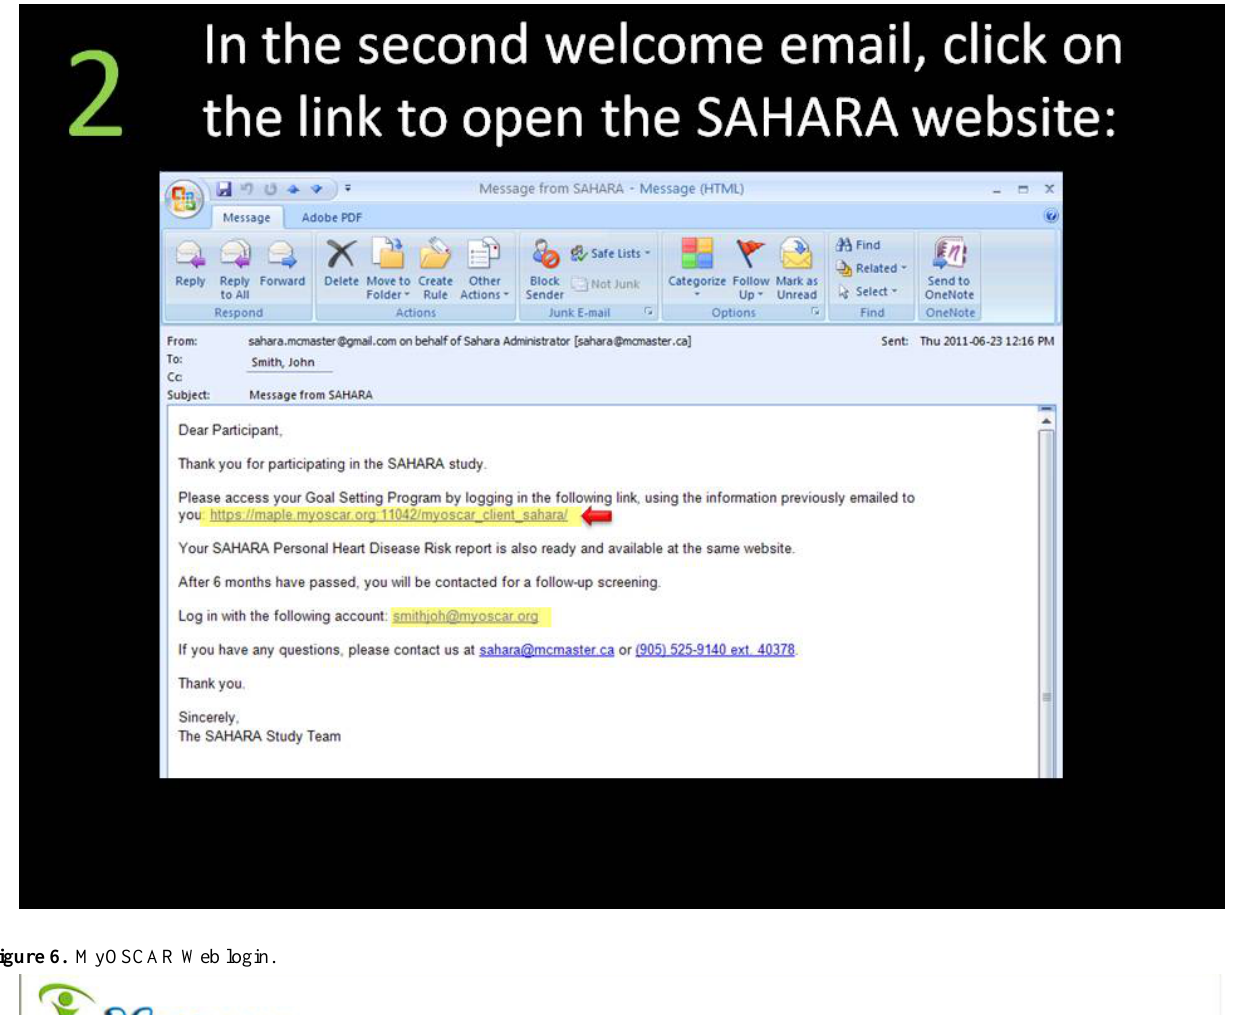
Figure 5. Second welcome email.